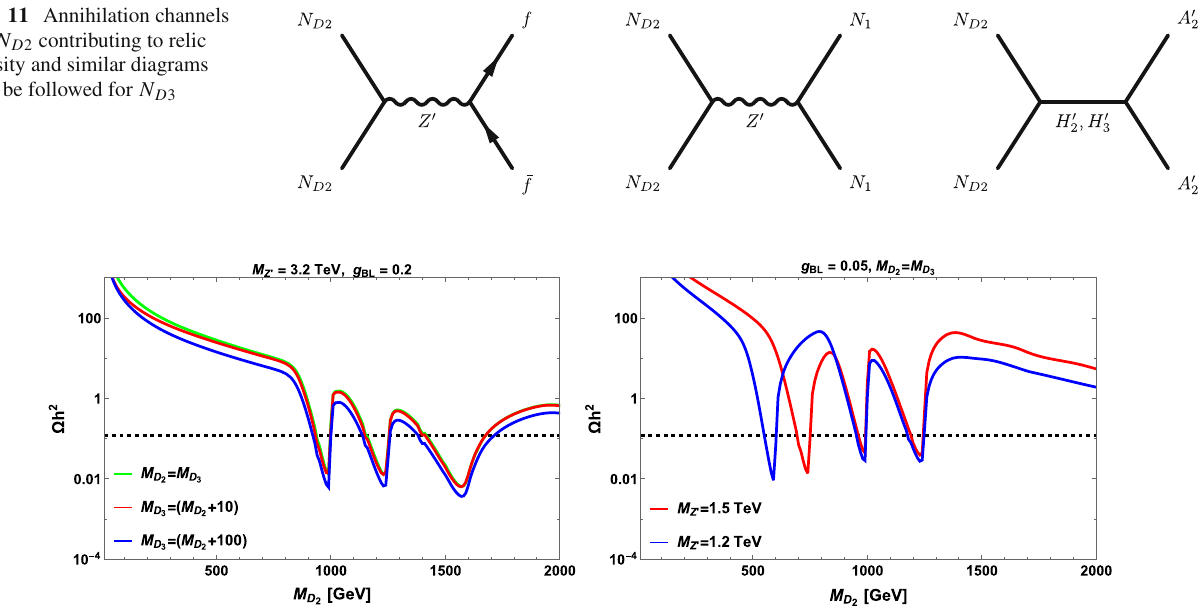
, M , M , M , M ) = ( 2 . 2 , 2 , 2 . 5 , 2 . 1 , 0 . 9 ) H (cid:2) 2 H (cid:2) 3 A (cid:2) 1 A (cid:2) 2 1